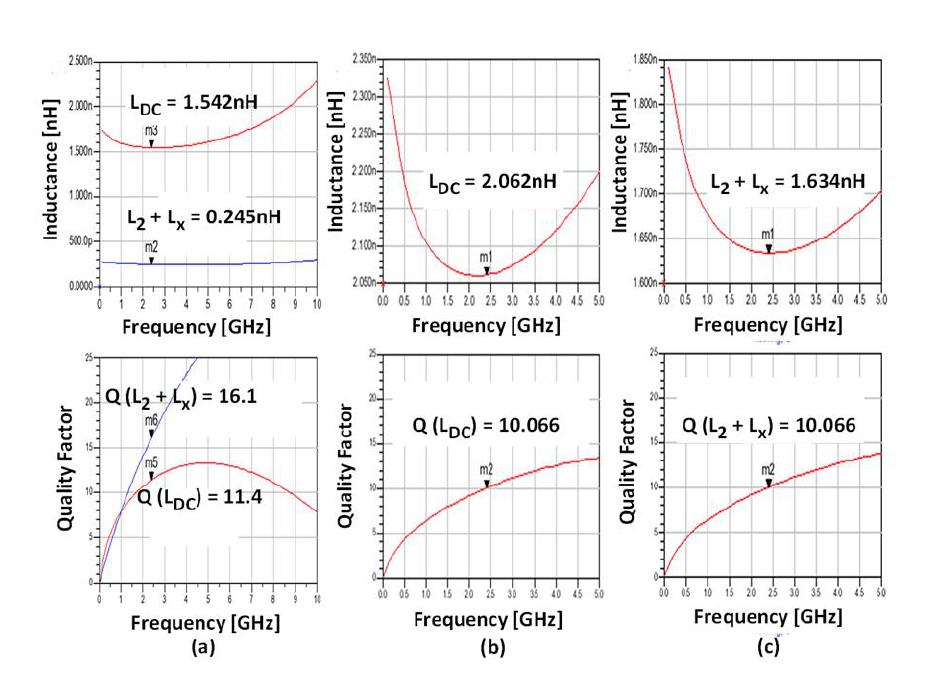
Figure 6. The quality factor plotted versus frequency for the inductors: ( a ) Coupling-inductors; ( b ) DC-feed inductor; ( c ) Output series